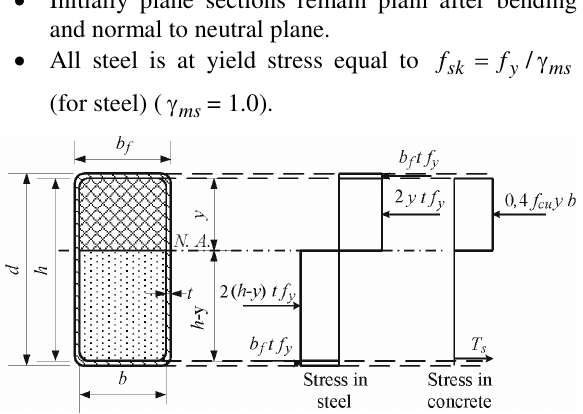
Fig. 1. Stress distribution in concrete-filled hollow sections at u